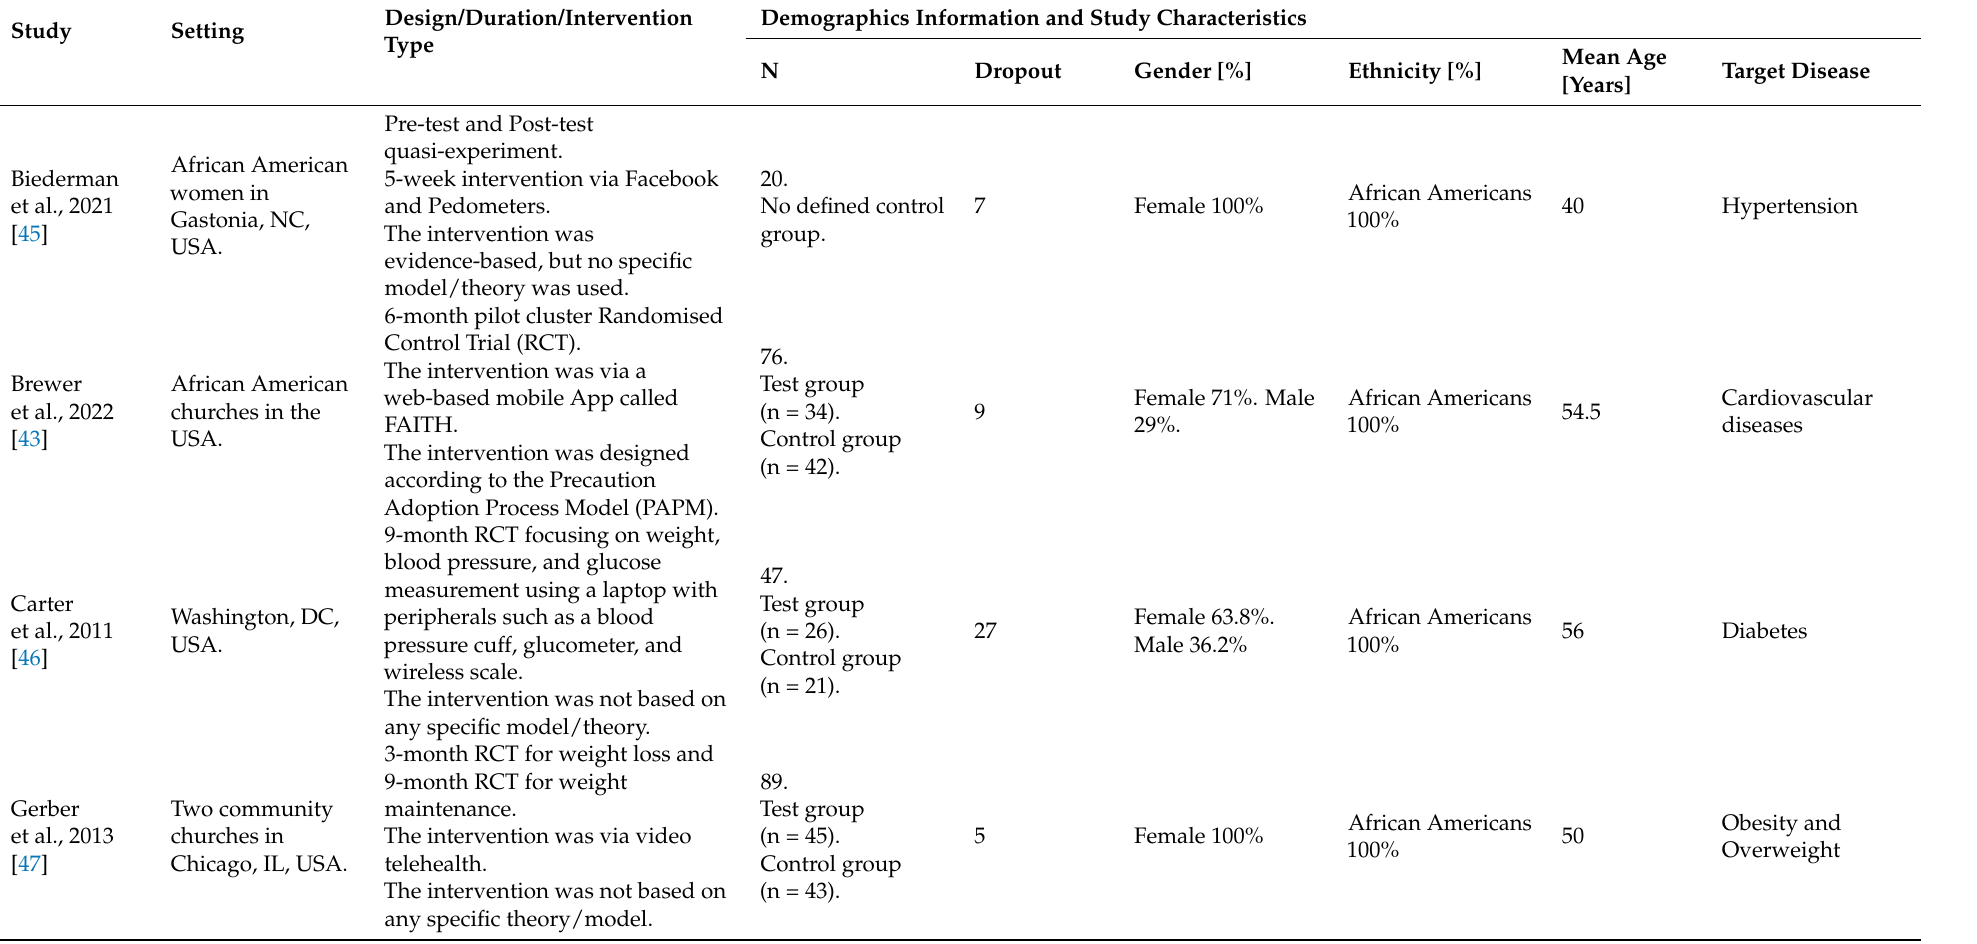
Table 3. Summary of Study